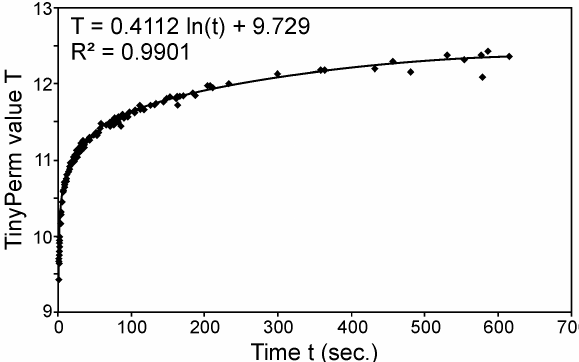
Fig. 3. Cross-plot of TinyPerm II value ( T ) with needed measuring time ( t ) in seconds. Note the asymptotic behaviour of the regression line with increasing measuring